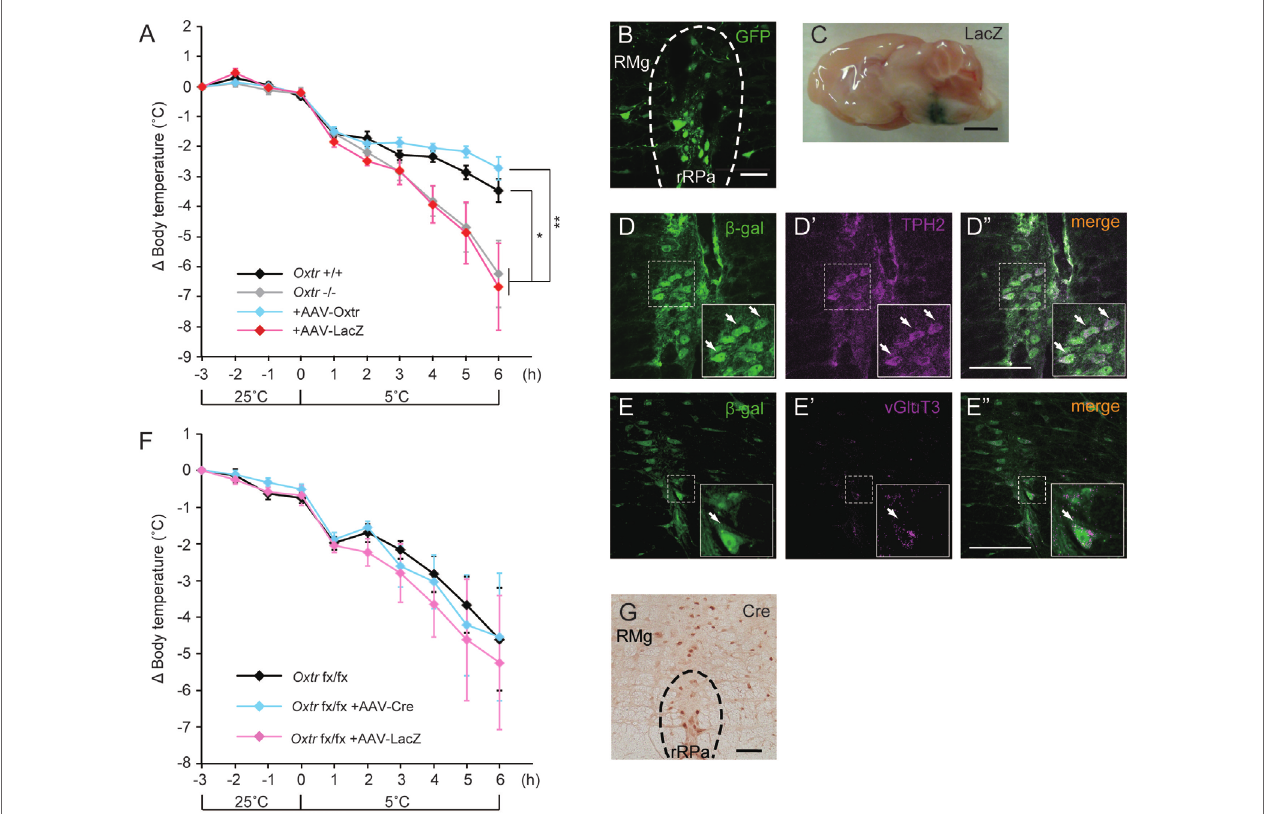
FigUre 2 | Malfunction of thermoregulation in Oxtr -deficient animals was rescued by aaV-Oxtr injection . (a) Core body temperature was measured in 10- to 13-week-old male Oxtr + / + ( n = 9), Oxtr − / − ( n = 8), + AAV-Oxtr ( n = 8) and + AAV-LacZ ( n = 8) mice. The data of Oxtr − / − and + AAV-LacZ mice were treated as Oxtr -deficient group in this experiment. Dysfunction of body temperature control in Oxtr -deficient group was rescued by AAV-Oxtr injection into the RMR. (B) Immunohistochemical images with anti-GFP antibody on the rRPa of AAV-Oxtr-Venus-injected mice. (c) Injection site was visualized by LacZ-staining. (D) Double immunostaining of TPH2 and β -gal on the rRPa of AAV-LacZ injected mice. (e) Double immunostaining of vGlut3 and β -gal on the rRPa of AAV-LacZ injected mice. (F) Core body temperature was measured in 10- to 13-week-old male Oxtr fx/fx ( n = 5), + AAV-Cre ( n = 5), and + AAV-LacZ ( n = 5) mice. Region-specific deletion of Oxtr in the RMR did not cause any diminished thermoregulatory ability. (g) Immunohistochemical images with anti-Cre antibody on the rRPa of AAV-Cre injected mice. * p < 0.05, ** p < 0.01, significant differences between groups. Scale bar: 50 μ m (B) , 2 mm (c) , 100 μ m (D,e,g)